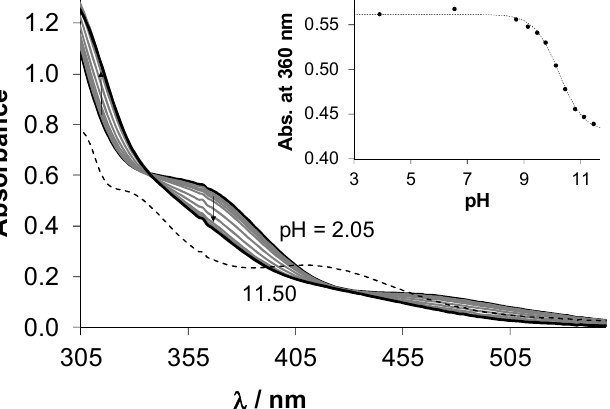
Figure 5. UV-vis absorption spectra recorded for complex 1 in the presence of 200 mM chloride ions at various pH values (solid lines), in addition to the summed spectra of the unbound ligand pyrithione and [Ru( η 6 - p -cymene)(H 2 O) 3 ] 2+ at pH 2 (dashed line) using the same concentration of the complex, ligand and metal precursor in the samples. Inserted figure shows the absorbance values of complex 1 at 360 nm plotted against the pH. { T = 25.0 °C, I = 0.2 M KCl, c complex 1 = 250 μM; l = 1 cm}.